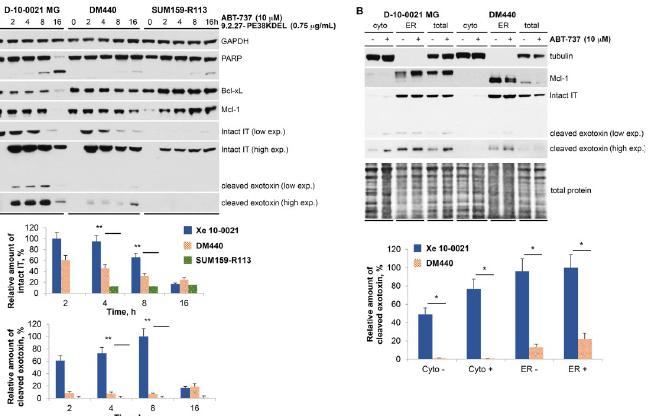
Fig 4. Detection of Bcl-xL, Mcl-1, PARP cleavage, intact IT, and intracellular localization of cleaved exotoxin at indicated time points following the treatment of ABT-737 and 9.2.27-PE38KDEL combination in D-10-0021 MG, DM440, and SUM159-R113. A. Expression of Bcl-xL, Mcl-1, cleaved PARP, and cleaved IT at various time points following the combination treatment of 10 μ M ABT-737 and 0.75 μ g/ml 9.2.27-PE38KDEL in D-10-0021 MG, DM440, and SUM159-R113 cells. The total intracellular extract was used for the analysis. Upper panel represents western blot analysis, and the lower panel displays relative accumulation of furin processed exotoxin in different cell lines. B. Distribution of intact IT and cleaved exotoxin in the cytosol, ER, and total lysates of D-10-0021 MG and DM440 cells, at 4 h post treatment of 0.75 μ g/ml 9.2.27-PE38KDEL alone or in combination with 10 μ M ABT-737. Upper panel represents western blot analysis and the lower panel displays relative localization of cleaved exotoxins in the cytosolic and ER compartments. The values represent the average of 3 experiments, and the error bars represent SEM, and the asterisks indicate significance determined by Student’s t-test ( � : p < 0.05, �� : p <